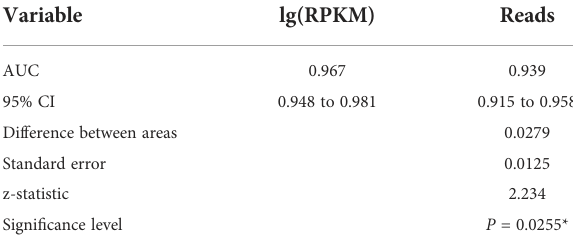
TABLE 3 Pairwise comparison of ROC